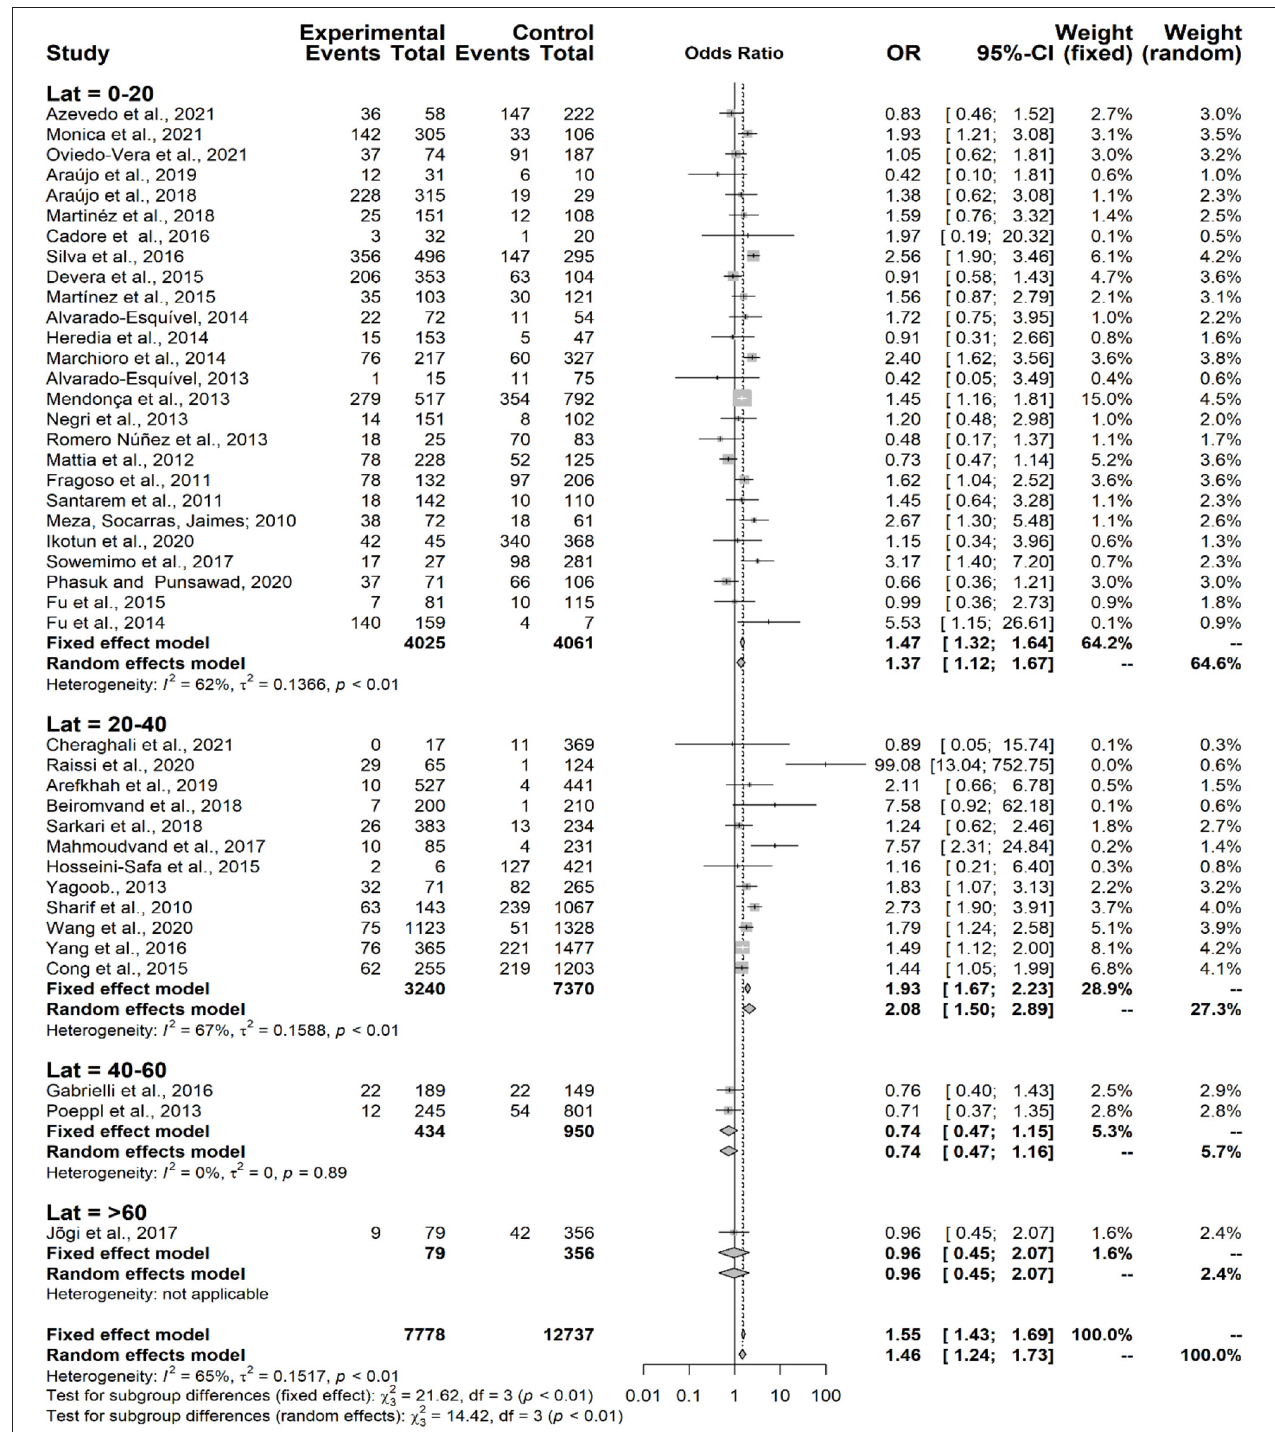
FIGURE 6 | Forest plot for assessment of odds-ratio of influence of geographical latitude (Lat = degrees) in the frequency of anti- Toxocara antibodies in participants, according to selected articles used in the meta-analysis from 2009 to 2021.